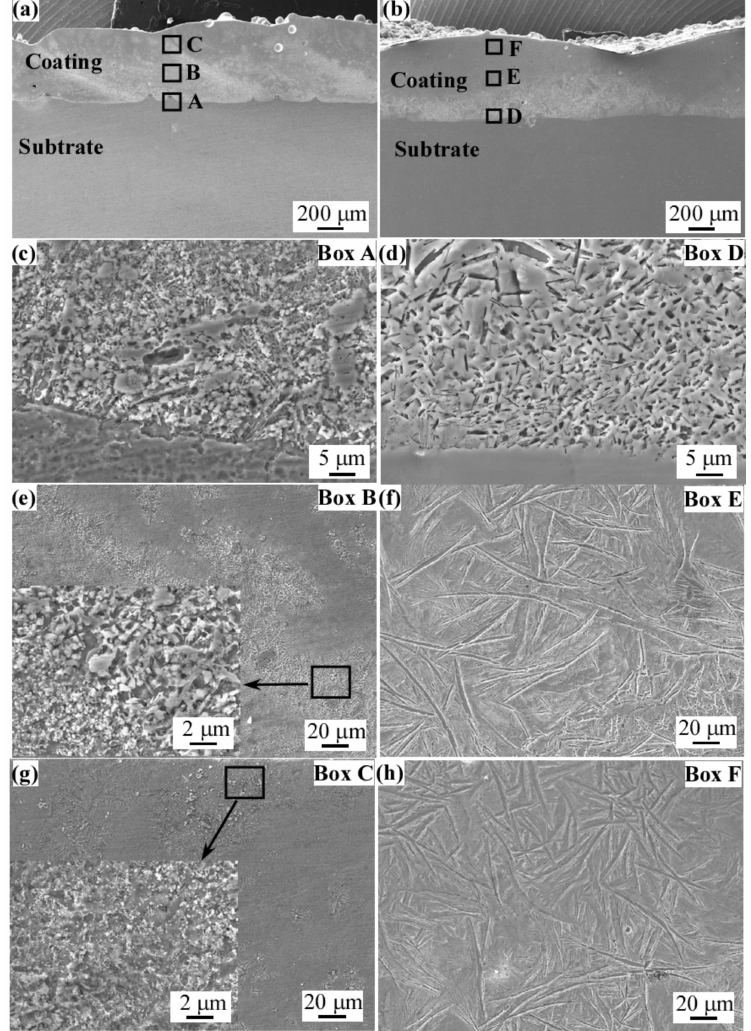
Figure 4. Cross-sectional morphologies of ( a ) FeCoNiCrBSiNb and ( b ) FeCoNiCrBSiY coatings. Figure ( c , e , g ) are the microstructures of the A, B and C regions in Figure ( a ). Figure ( d , f , h ) are the microstructures of the D, E and F regions in Figure ( b